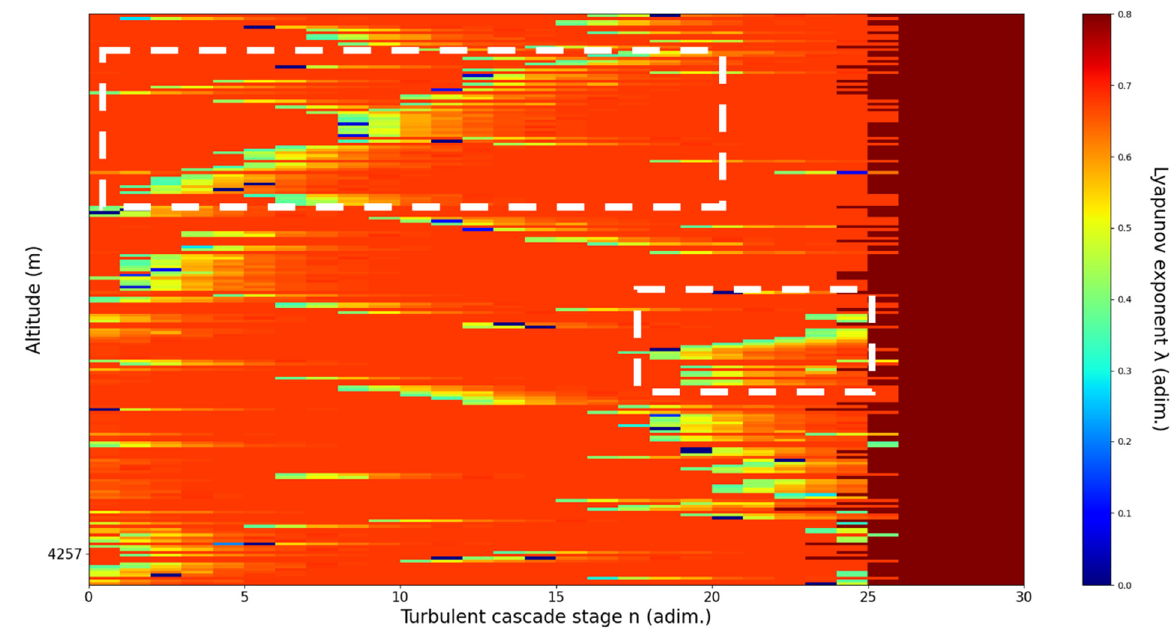
Figure 11. Lyapunov exponent per turbulent cascade stage colormap altitude plot, Bucharest, Romania, 13 June